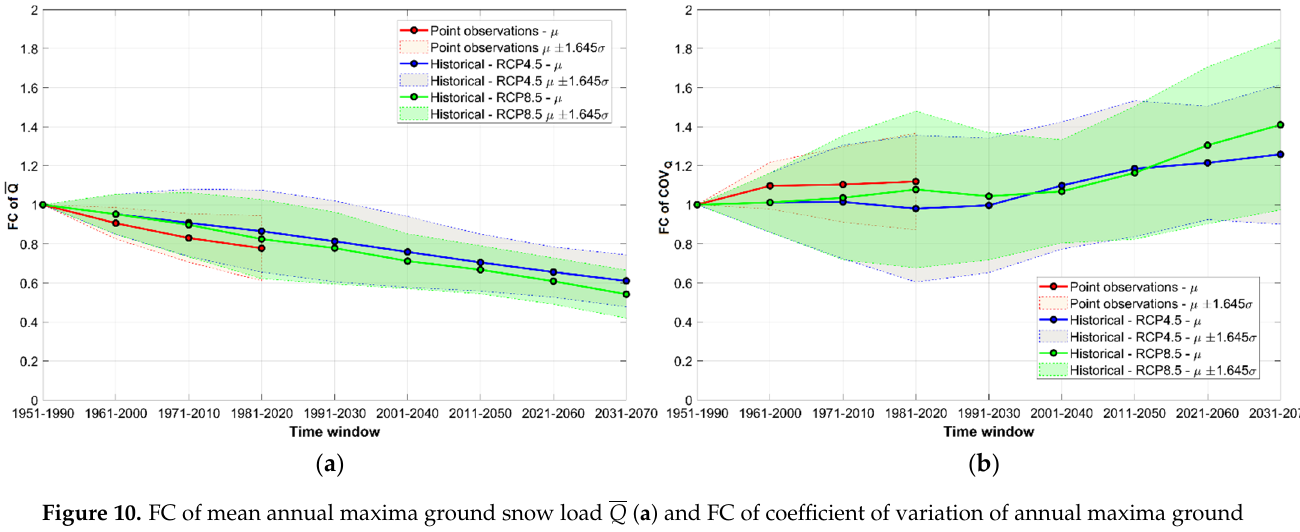
Figure 10. FC of mean annual maxima ground snow load Q ( a ) and FC of coefficient of variation of annual maxima ground snow load COV Q ( b ), for the investigated weather stations. Average value µ and confidence interval µ ± 1.645 σ are shown according to point observations (in red) and regional climate model projections depending on the scenario RCP4.5 (in blue) and RCP8.5 (in green).